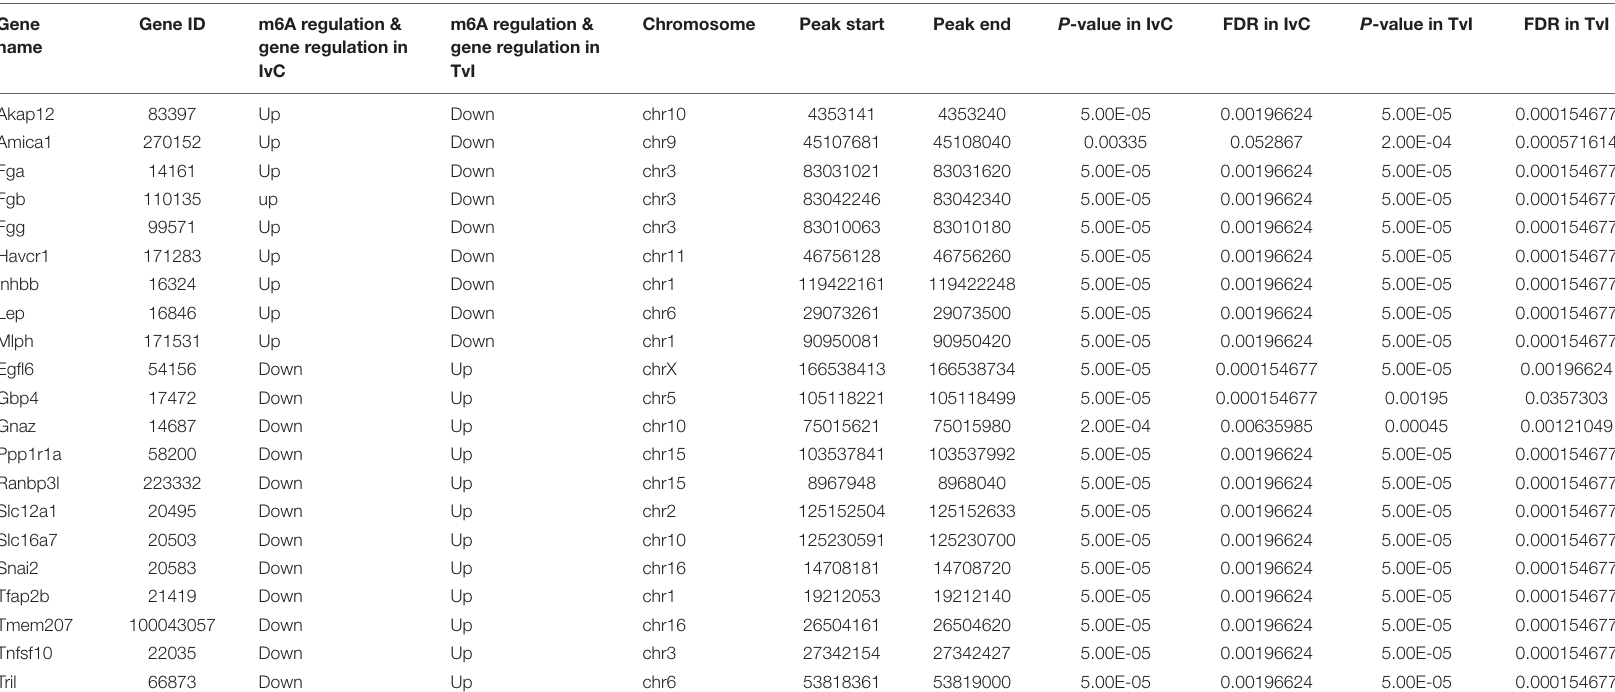
TABLE 3 | Genes with contrary methylation and expression trends between IvC and